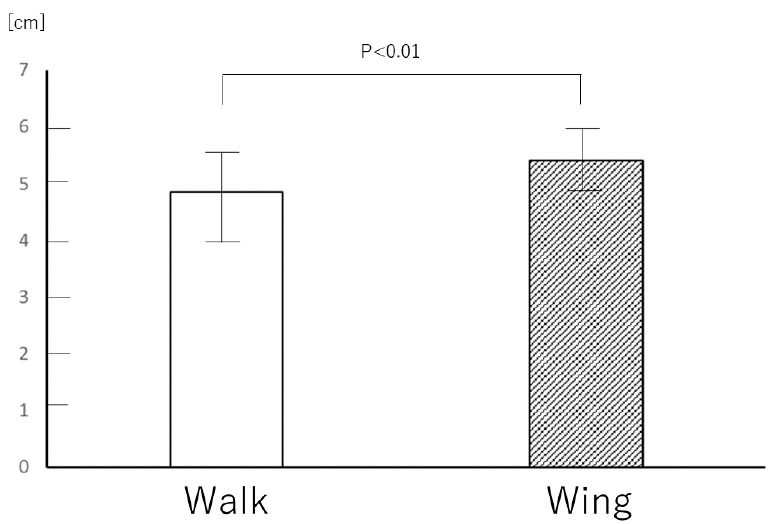
Figure 3. The difference between the average chest compression depths achieved in the walk and wing methods (5.40 ± 0.50 cm vs. 4.85 ± 0.80 cm; p < 0.01). The white bar represents the walk method and the grey bar represents the wing method. The data were analyzed by paired t-test.